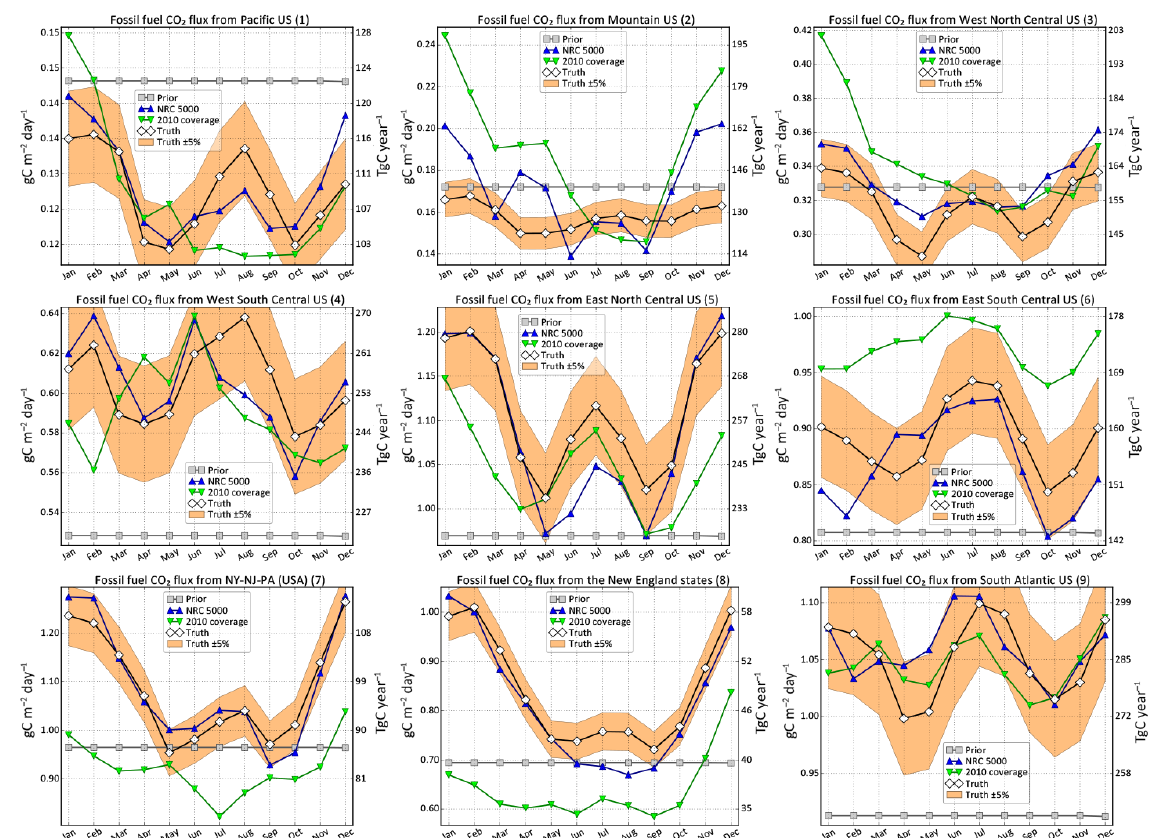
Figure 7. Monthly total emissions estimates for 2010 and NRC 5000 network scenarios, along with prior and true fluxes for individual regions identified in Fig. 5. The orange band depicts the ± 5% margin around the true fluxes, and the numbers next to region names refer to the region labels in Fig. 5.